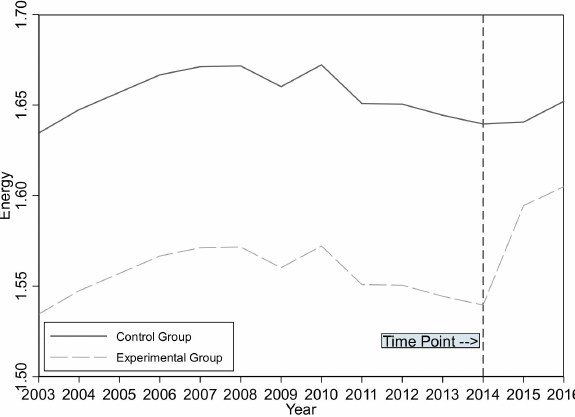
Figure 2. Parallel trend in energy